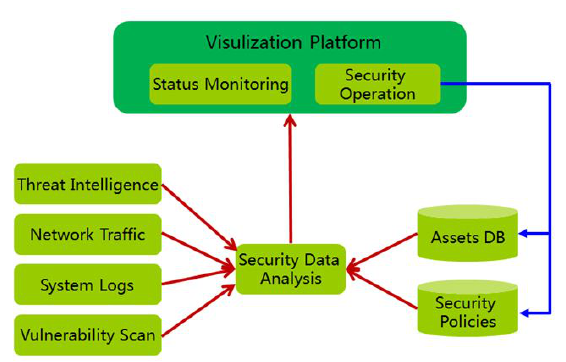
Figure 3. Architecture of security detection and monitoring system